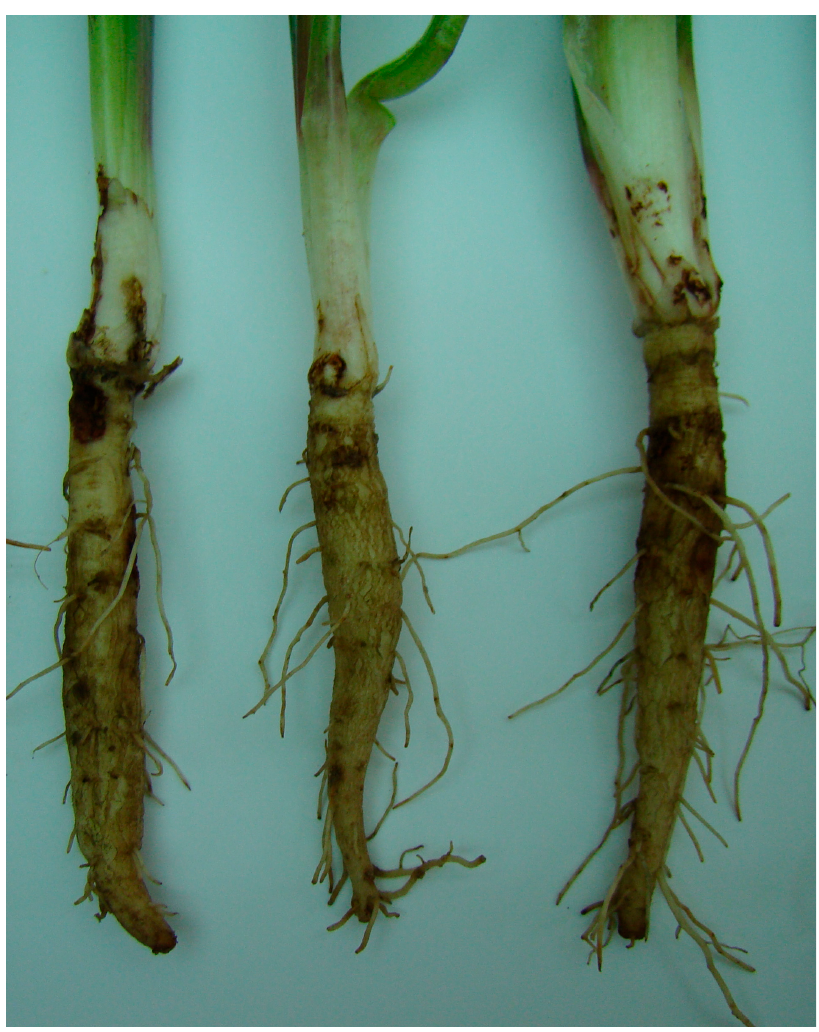
Figure 1. Necrosis on the roots of scorzonera seedlings; (photo by E. Patkowska).